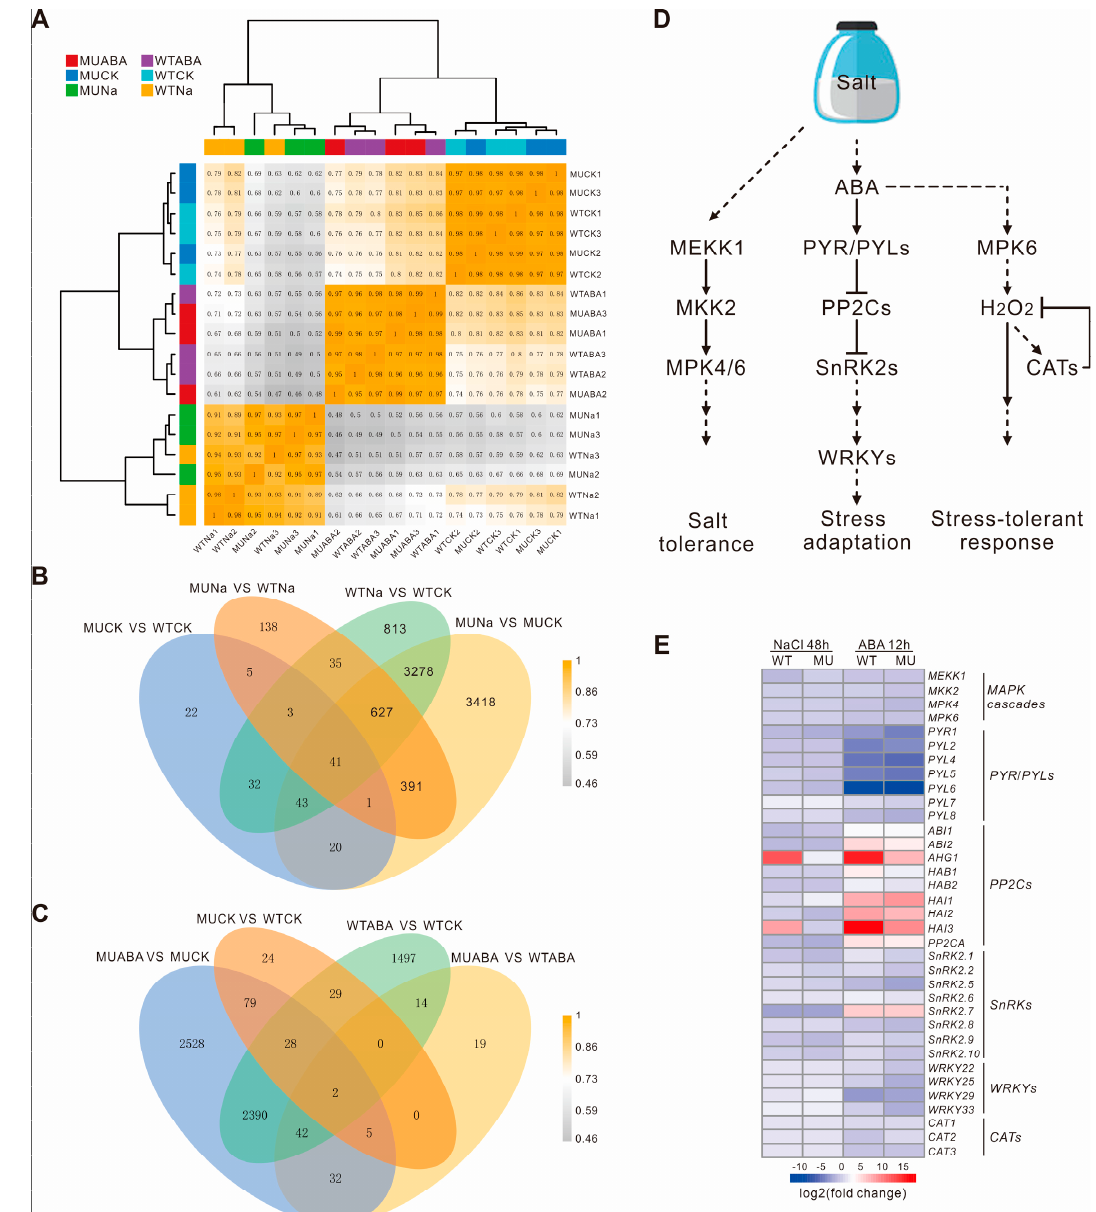
Figure 7. Changes of related gene expressions between the WT and Atwrky66 transgenic plants after salt stress or ABA treatments. ( A ). Sample–sample correlation heatmap of 18 samples. ( B ). Venn diagrams of the differentially expressed genes (DEGs) in different comparisons after NaCl treatments. ( C ). Venn diagrams of the DEGs in different comparisons after ABA treatments. WT, wild type; MU, wrky66-14 ; Na, NaCl treatments; ABA, ABA treatments. ( D ). Schematic representation of the ABA-mediated signaling pathway based on KEGG analysis. MPK , mitogen-activated protein kinase; MKK , MPK kinase; MEKK , mitogen-activated protein kinase kinases; ABA, abscisic acid; PYR / PYL , PYRABACTIN RESISTANCE-LIKE; PP2C , protein phosphatase 2C; SnRK2 , sucrose non-fermenting 1 (SNF1)-related protein kinase 2; CAT , catalase. ( E ). Heatmap of ABA-mediated signaling pathway related genes in the WT and wrky66-14 plants under NaCl or ABA treatments. MU, wrky66-14 ; WT, wild type; NaCl, NaCl treatments; ABA, ABA treatments. The detailed information of the log 2 FC value was shown in Supplementary Table